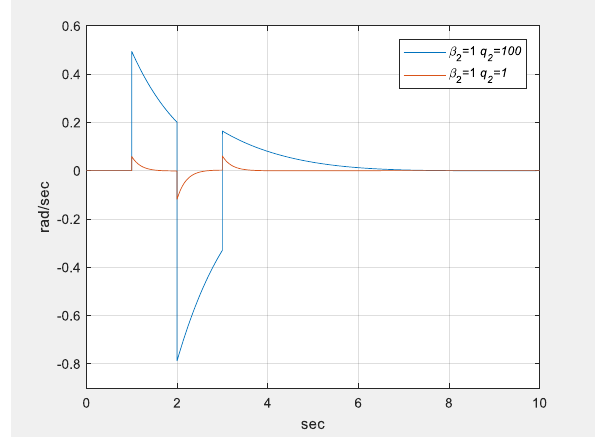
q on angular velocity. 2